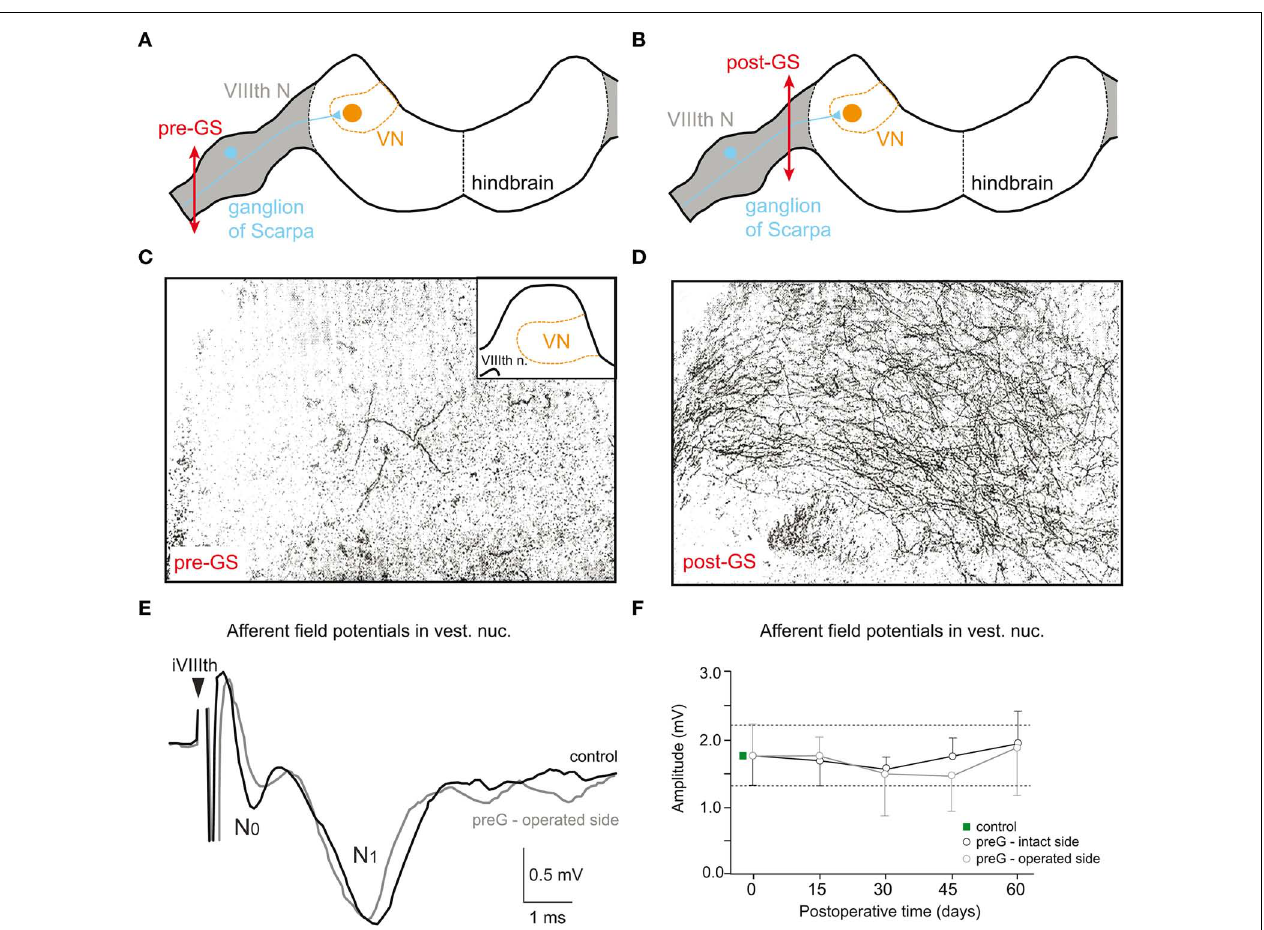
vestibular nerve afferent fibers were visualized by a silver impregnation method. (E,F) Pre- (N 0 ) and postsynaptic components (N 1 ) of ipsilateralVIIIth nerve-evoked afferent field potentials (E) recorded in theVN on the intact and operated side of chronic UL frogs with a pre-GS; mean amplitudes of the N 1 afferent field potential component, recorded on the intact (control) and operated side at different survival periods after a pre-GS (F) ; modified and adapted from Straka et al. (1993) and Kunkel and Dieringer